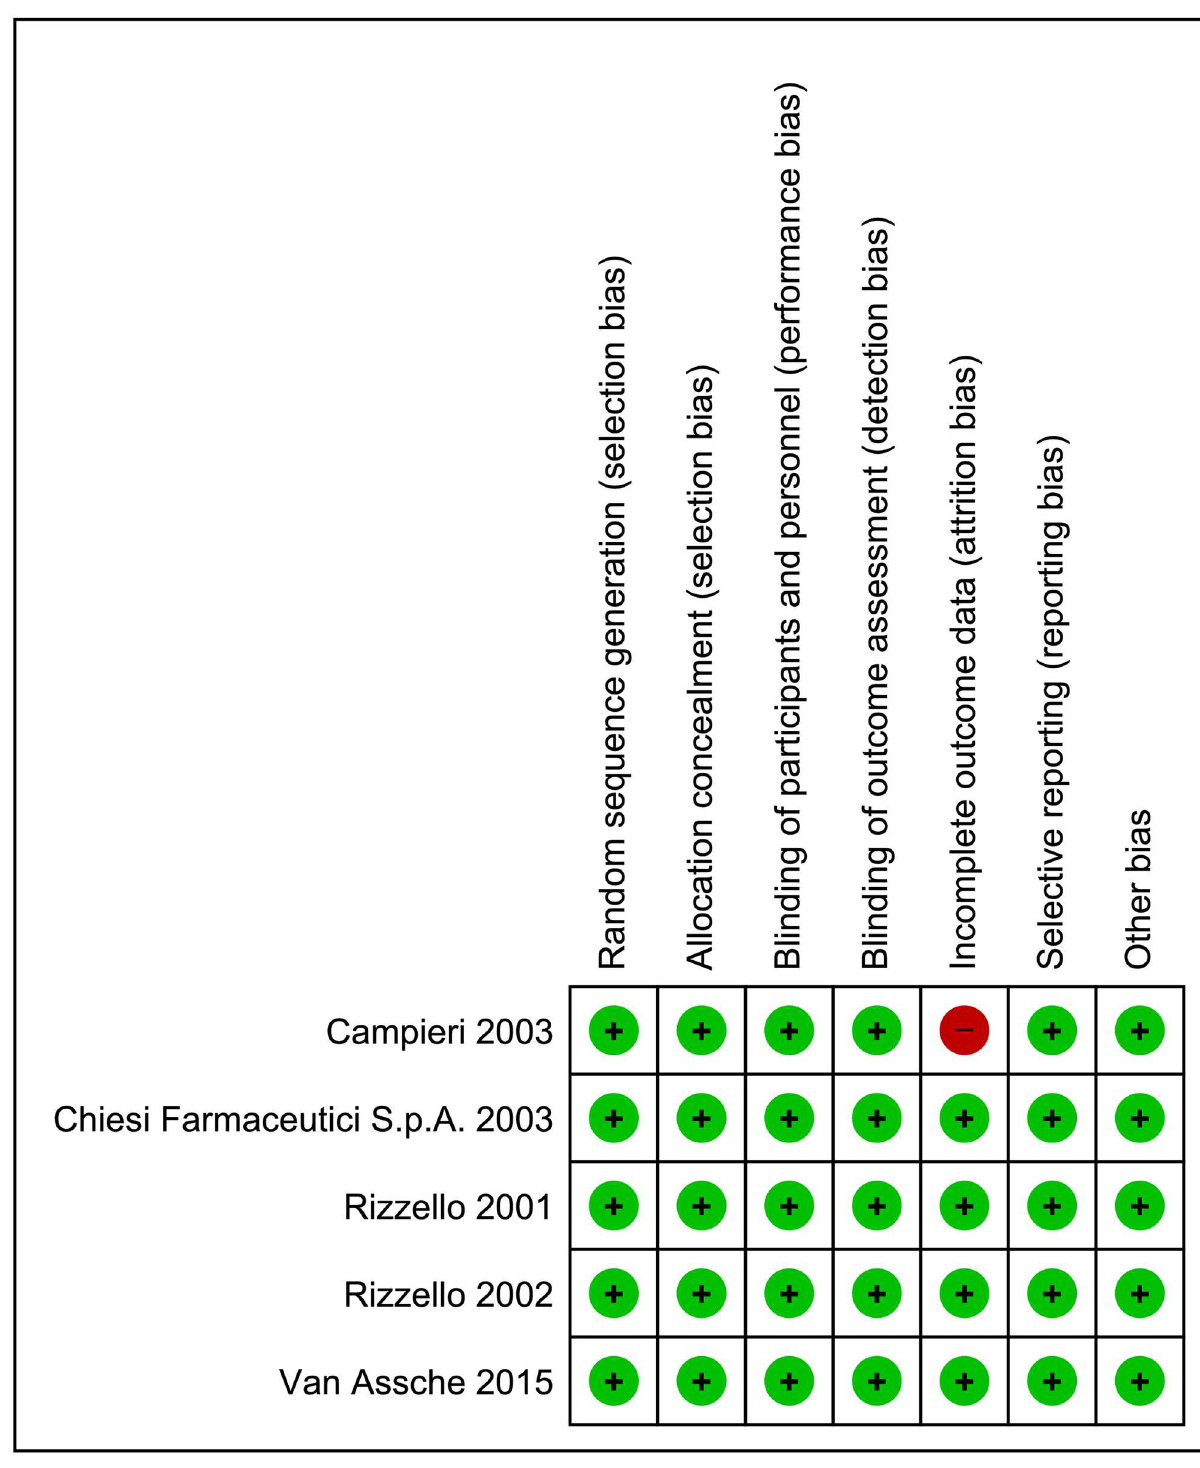
Fig 2. Risk of bias summary.This risk of bias tool incorporates the assessment of randomization (sequence generation and allocation concealment), blinding (participants and outcome assessors), incomplete outcome data, selective outcome reporting and other risk of bias. The items were judgedas ‘low risk’ ‘unclearrisk’ or ‘high risk’. Green means ‘low risk’ and red means ‘high